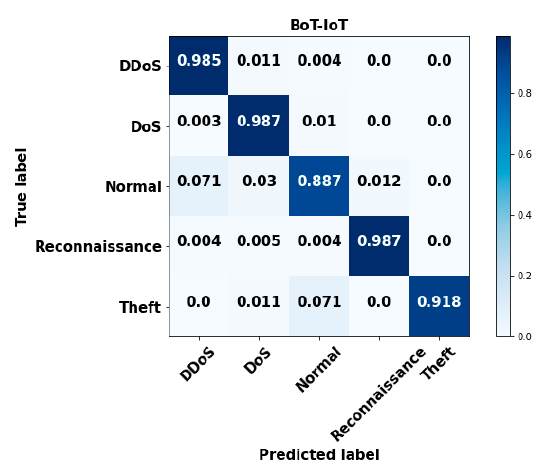
Figure 13. Confusion matrix for dataset 4.